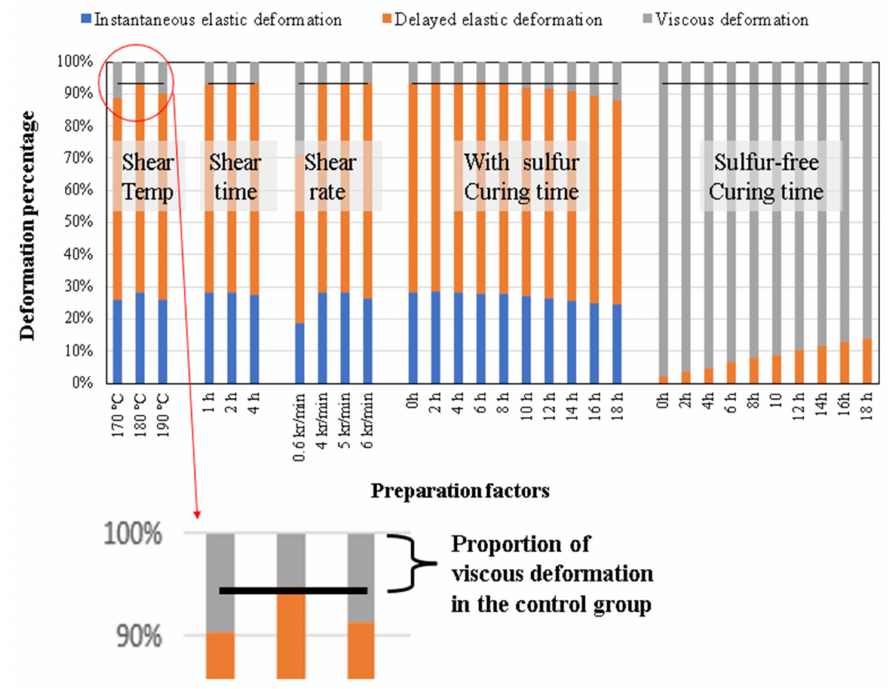
Figure 12. Cumulative proportions of the three deformations at the end of